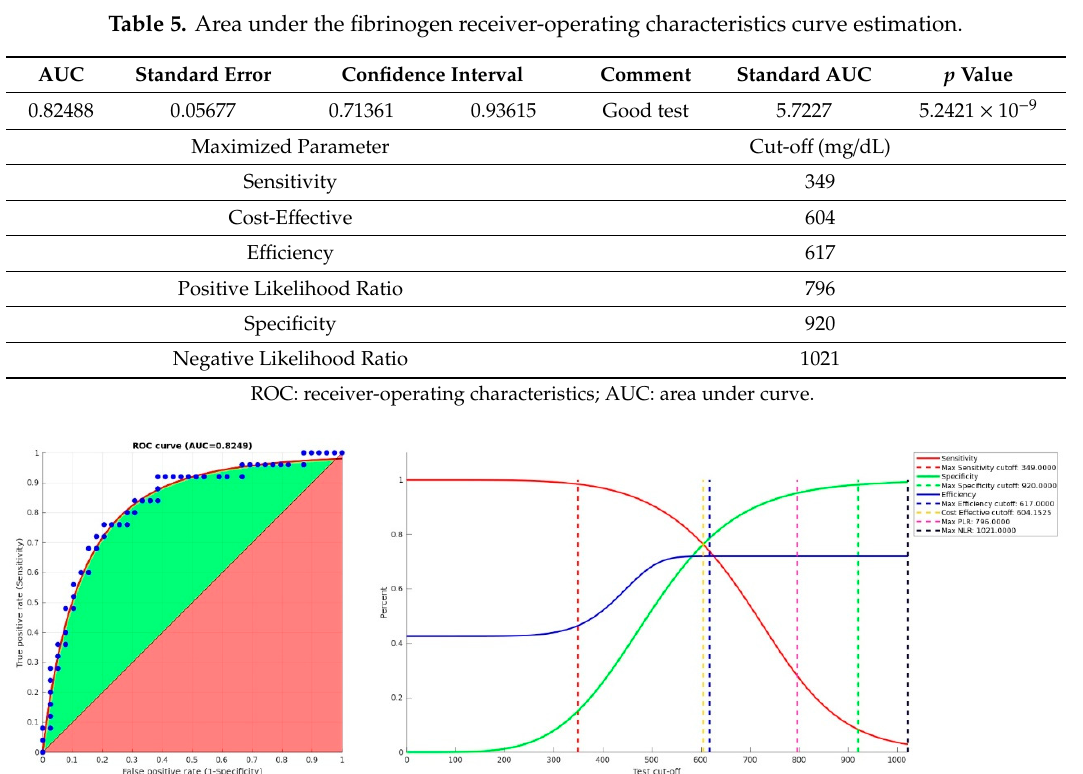
Figure 1. ROC curves of fibrinogen as a predictor of COVID-19 ARDS. On the left, the green area is the gain above the chance, represented by a red area of 0.5; on the right, sensitivity (red full line), specificity (green full line), and e ffi ciency (blue full line) are functions of fibrinogen concentration (mg / dL). Dashed lines show cut-o ff s where parameters are maximized: at 349 mg / dL, sensitivity is max (in red); at 604 mg / dL, sensitivity and specificity are equal (in yellow); at 617 mg / dL, e ffi ciency is max (in blue); at 796 mg / dL, positive likelihood ratio is max (in magenta); at 920 mg / dL, specificity is max (in green); at 1021 mg / dL, negative likelihood ratio is max (in black).ROC: receiver-operating characteristics; AUC: area under curve; PLR: Positive Likelihood Ratio; NLR: Negative Likelihood Ratio. Table 6. Numbers and rates of clinical outcome events in the study